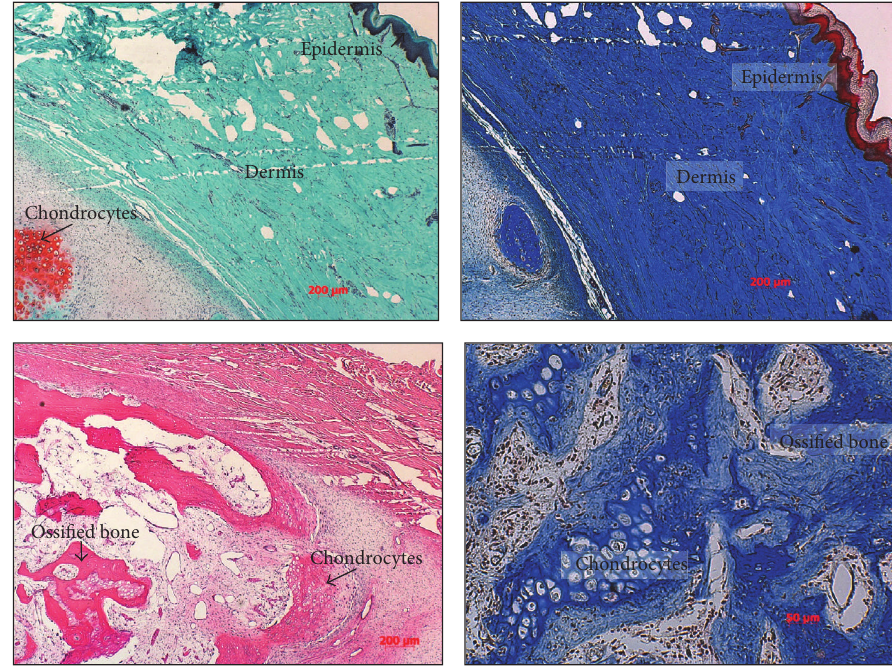
Figure 4: Safranin-O staining (25x) demonstrates calcified chondrocytes located just deep to the dermal area of the tissue (red). Masson’s Trichrome(25x)demonstratestheepidermal(red)anddermal(blue)layerthatisdirectlyadjacenttothechondrocyticarea.H&EandMasson’s Trichrome (25x) demonstrate endochondral bone formation adjacent to a cartilaginous cap indicating the formation of an